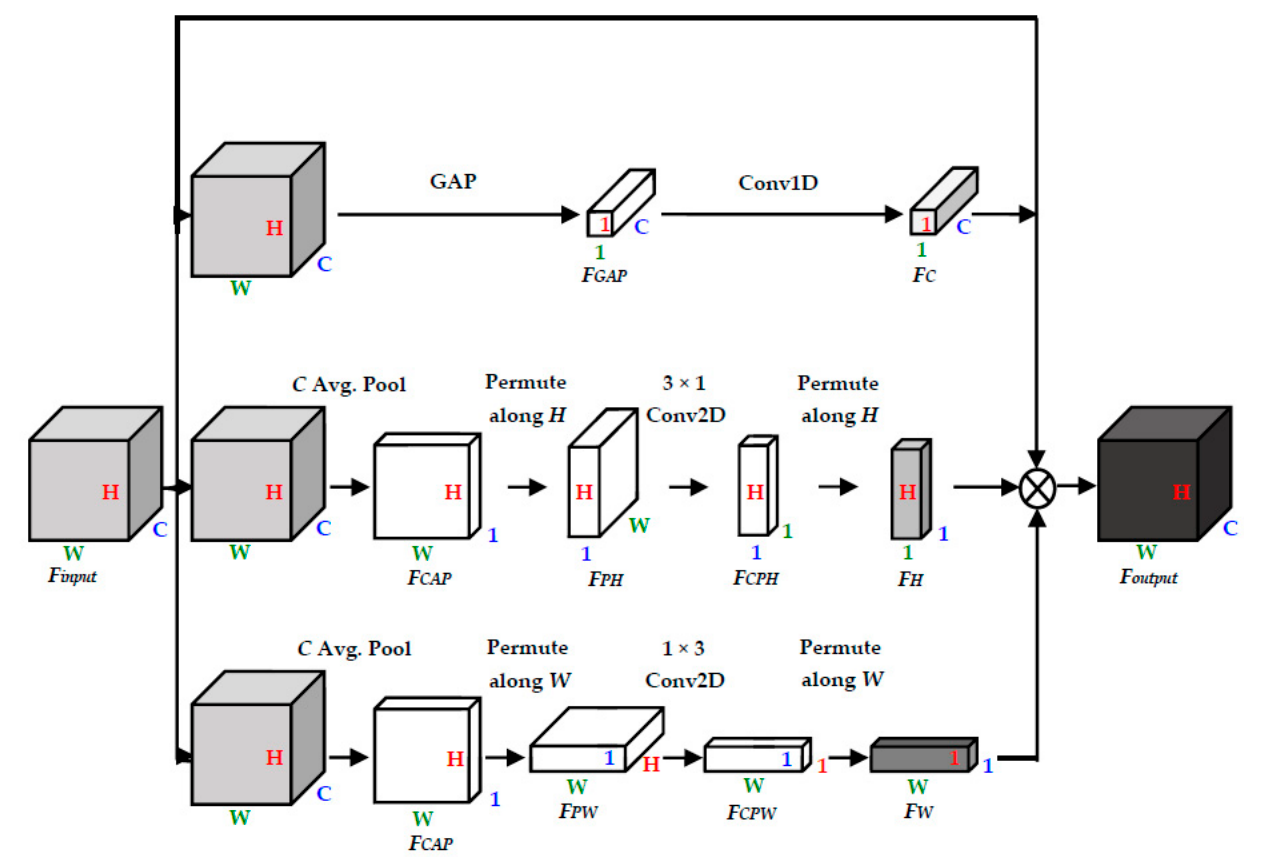
Figure 3. LCAM framework illustrated with block structure. The three branches arrange from top to bottom are, respectively, Channel Attention Branch (CAB), Vertical Attention Branch (VAB), and Horizontal Attention Branch (HAB).